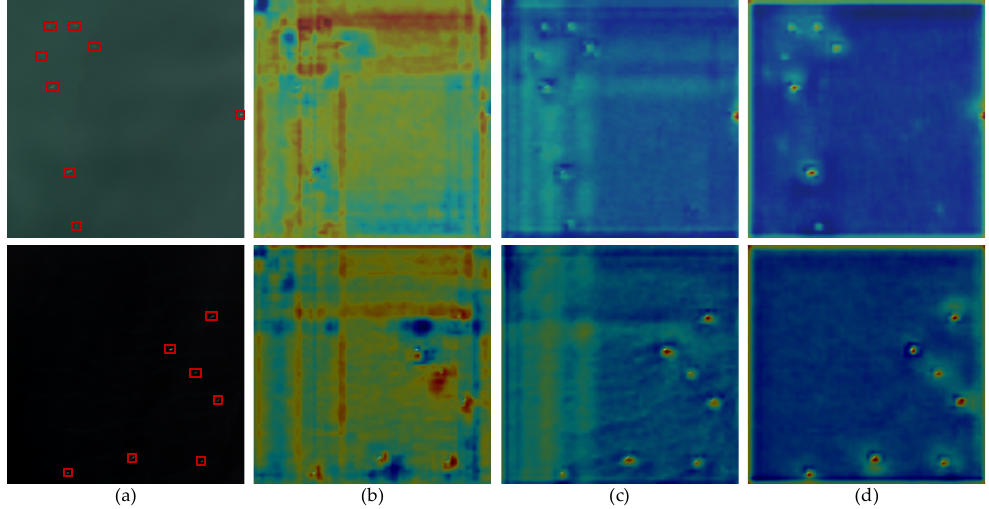
Figure 4. The visualization of feature maps of FPN generated by different networks. ( a ) The input RGB images. The ‘red boxes’ in the images indicate the locations of the objects. ( b ) The original feature maps produced by RetinaNet. ( c ) The feature maps produced by adding the FFA module. ( d ) The feature maps produced by